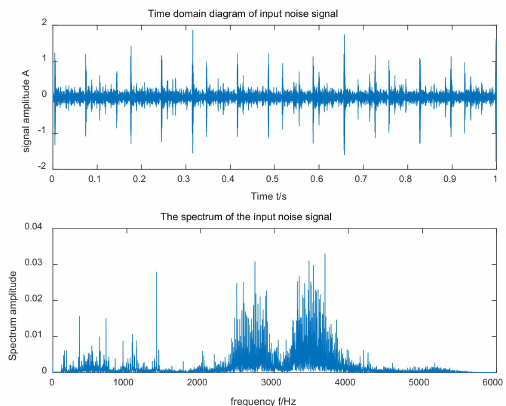
Figure 7. Input signal time domain waveform and FFT spectrum for the Western Reserve University dataset.